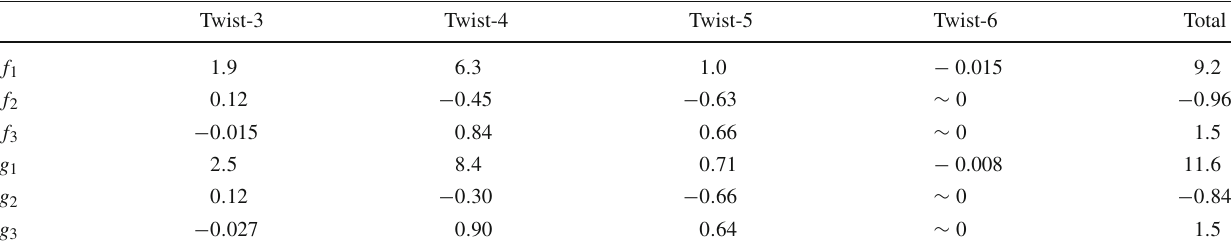
Table 3 Form factors in units of 10 − 3 from the leading-twist (cid:2) b baryon LCDA in Eq. (15) and the proton LCDAs of various twists